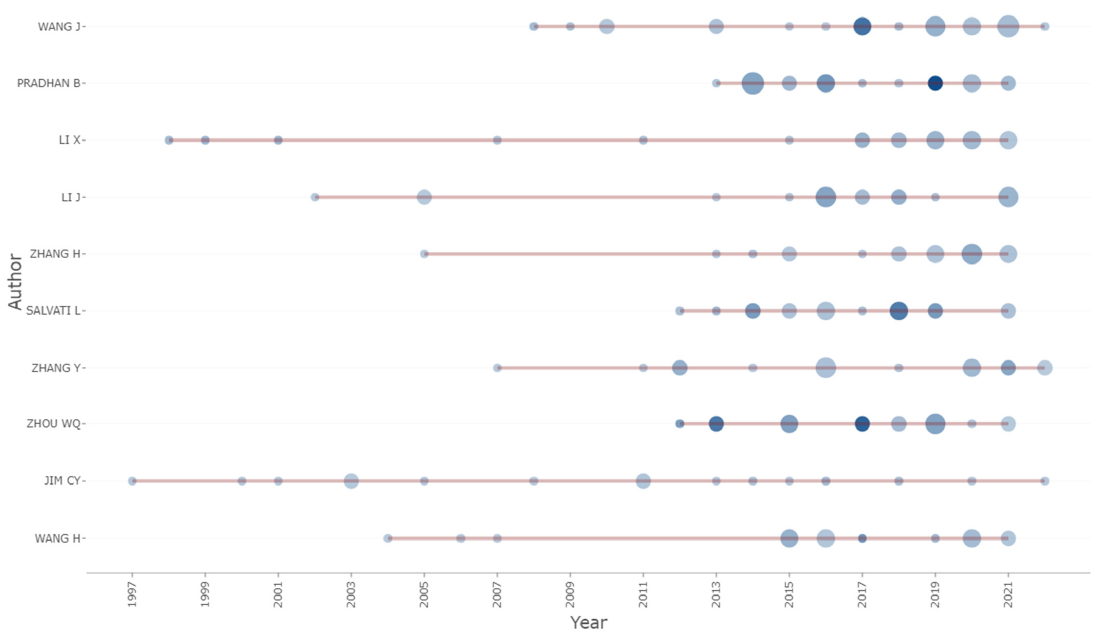
Figure 7. Long-term outcomes of highly cited authors in Web of Science in urban land management.